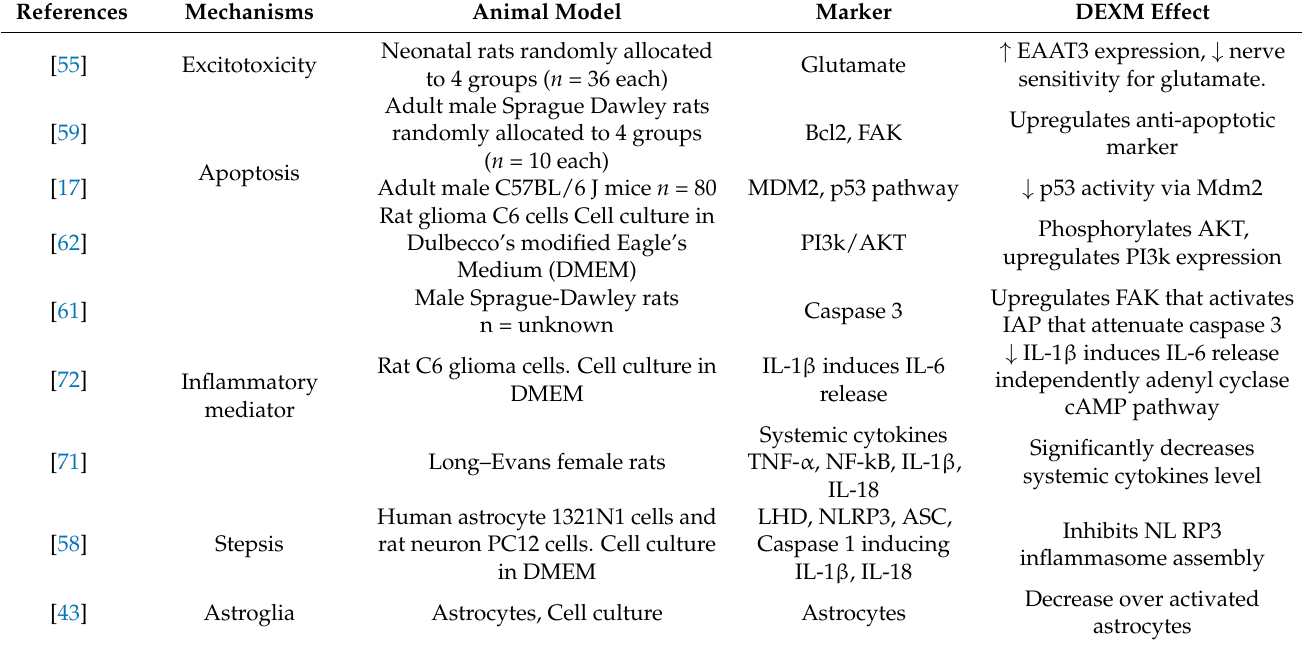
Table 2. Summary of DEXM-associated neuroprotective